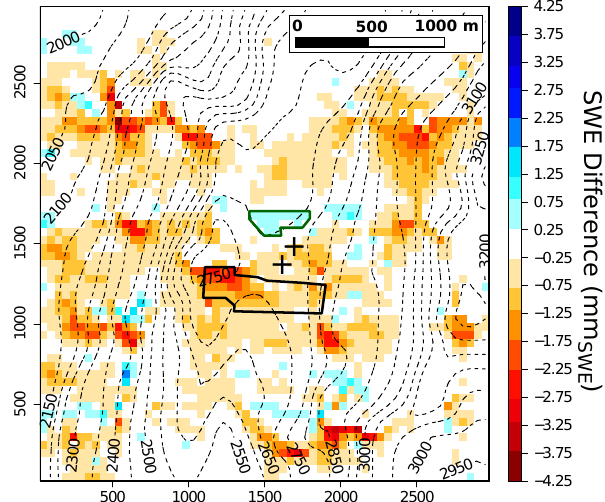
Fig. 12. Difference of SWE (mm SWE ) at the end of the blowing snow event between simulations SUBL and CTRL. The black box delineates the area whose mass balance is given in Table 5 while features of the region surrounded by the green box are discussed in the text. The spatial coordinates are in m and the dashed isolines correspond to 1z =